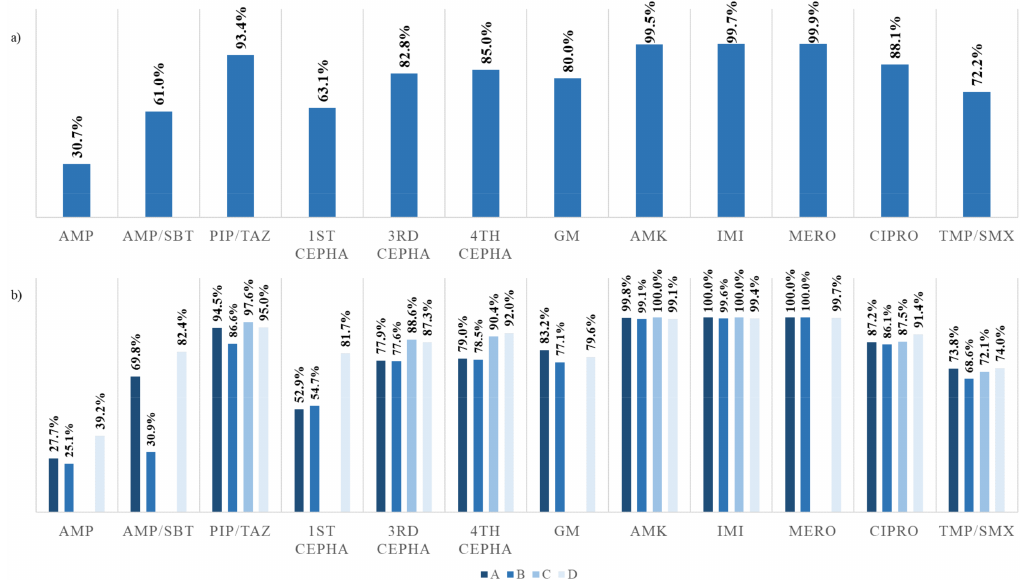
Figure 2. The pooled antimicrobial susceptibilities of ( a ) patients diagnosed with urinary tract infections (UTIs) in all four hospitals, and ( b ) in each of the four hospitals, A to D. AMP, ampicillin;